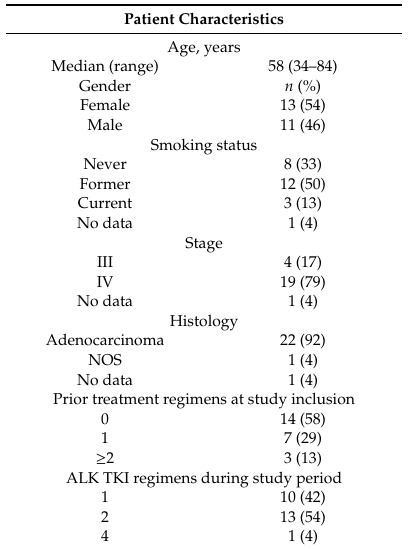
Table 1. Patient characteristics at diagnosis ( n = 24).